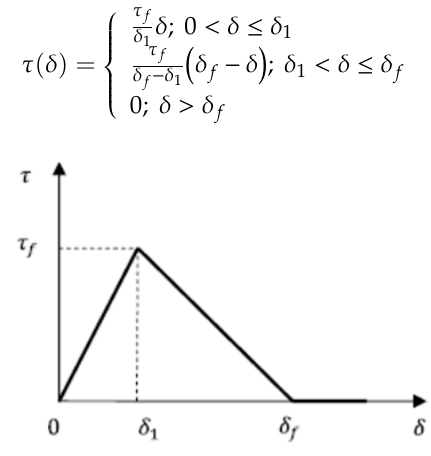
Figure 3. Bilinear bond-slip model.